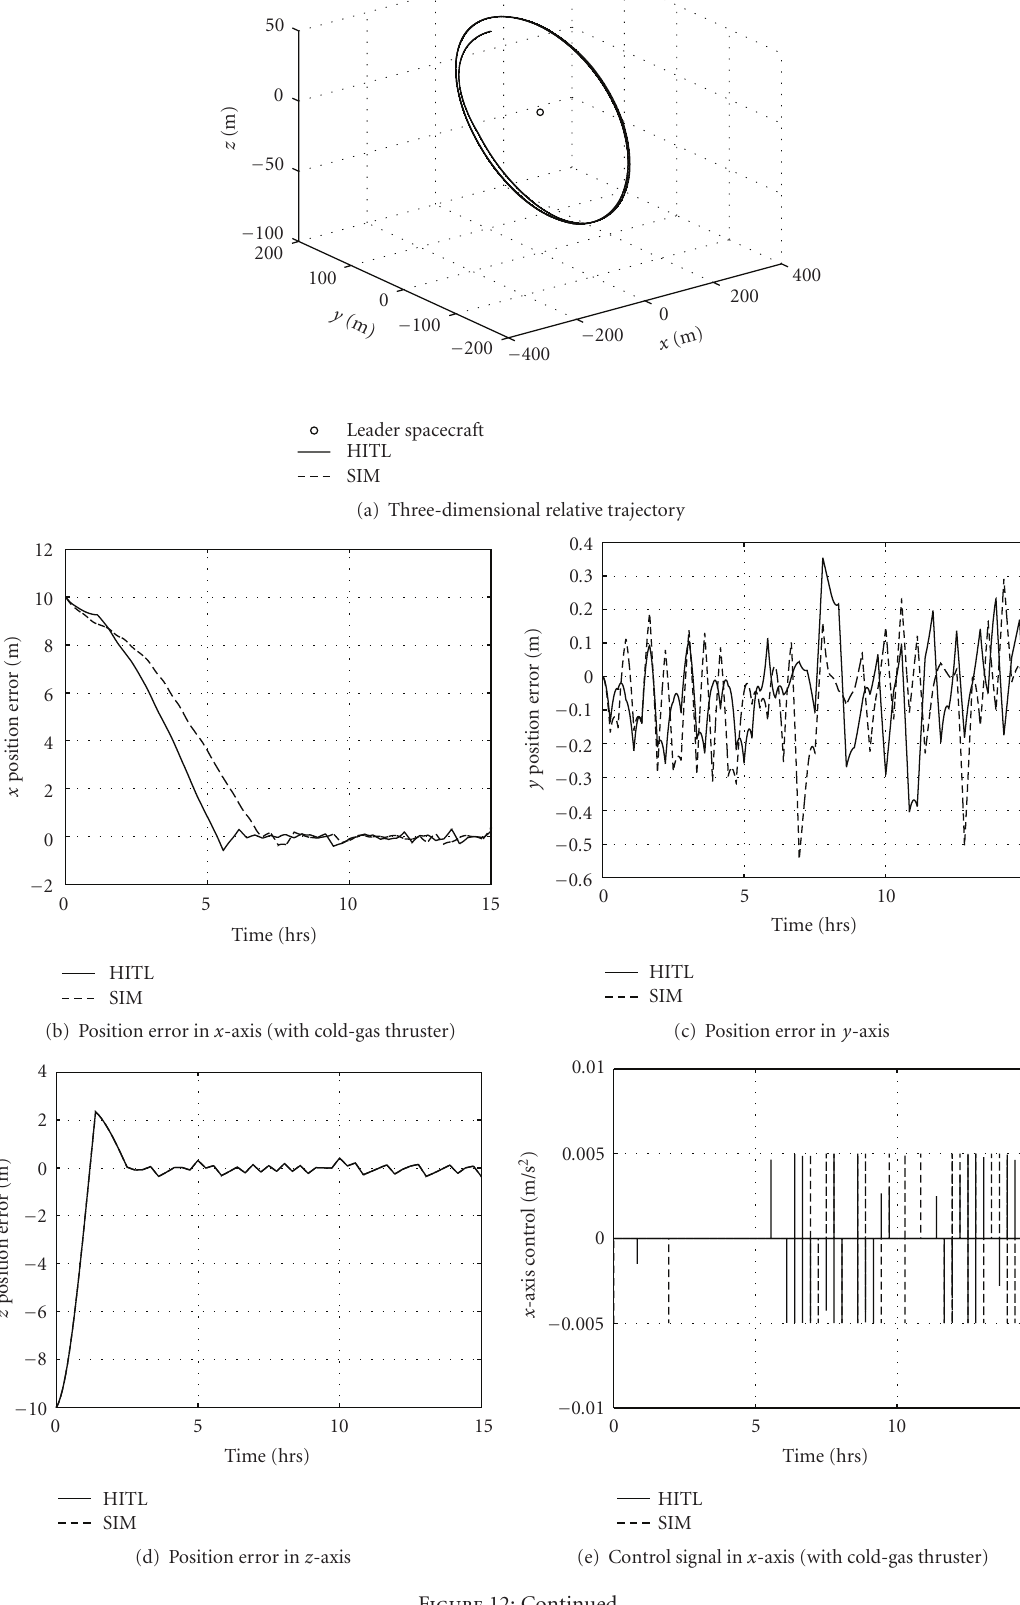
(a) Three-dimensional relative trajectory